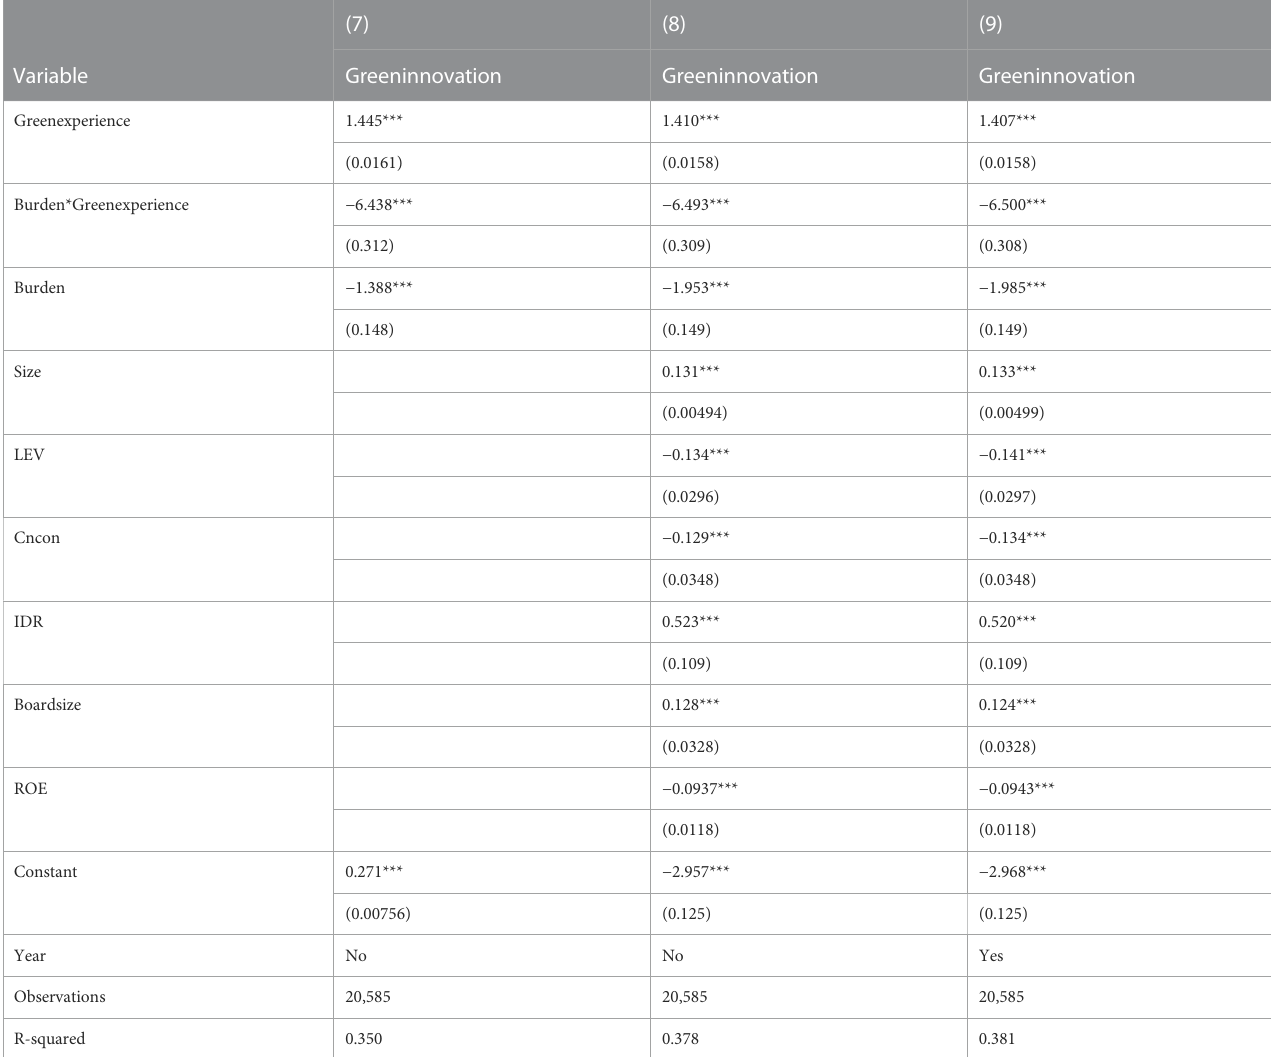
TABLE 6 Moderating effects of tax burden on CEO ’ s green ecological experience and green